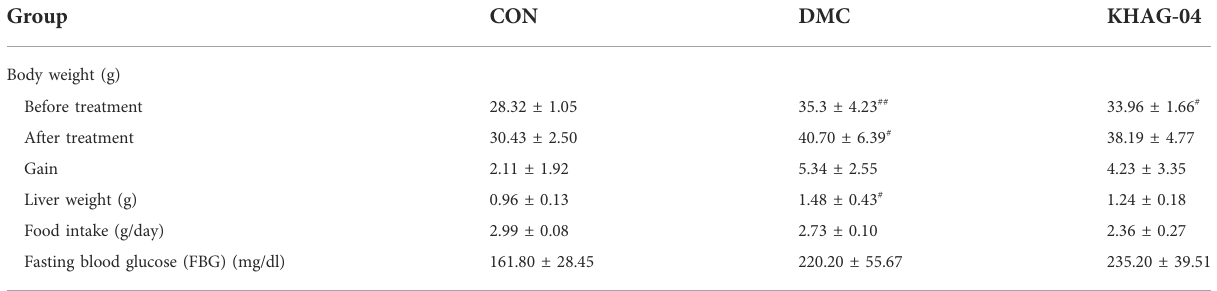
TABLE 1 Effect of KHAG-04 on body weight and food intake in the type 2 diabetes (T2DM) mice model. Group